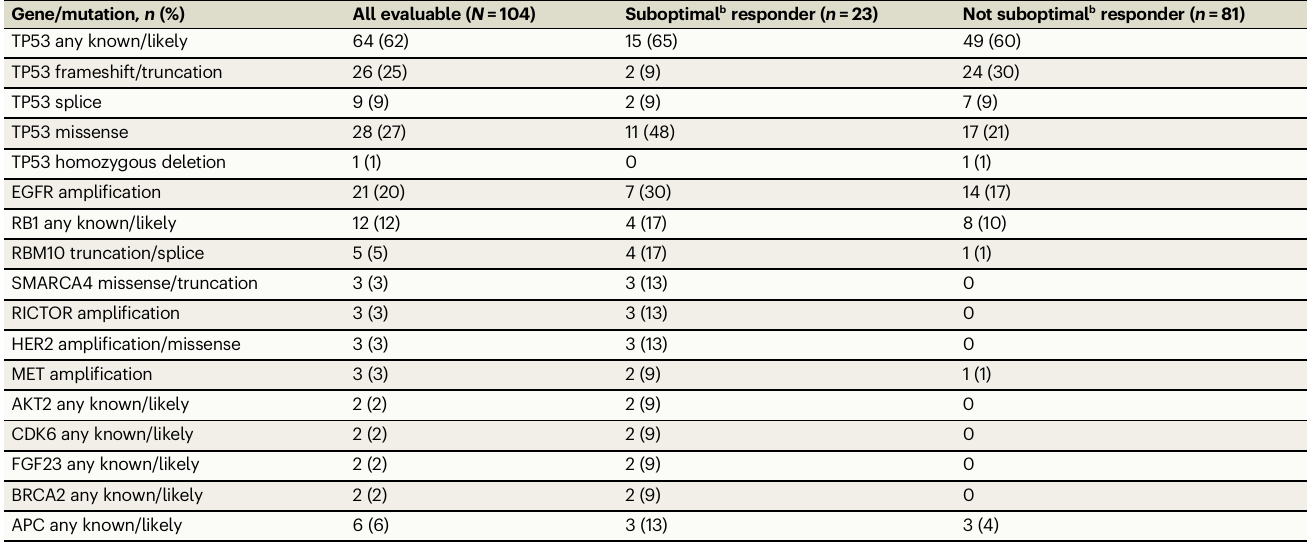
Table 2 | Summary of baseline genomic alterations in patients with valid tissue NGS result a and by suboptimal b tumor response to treatment or